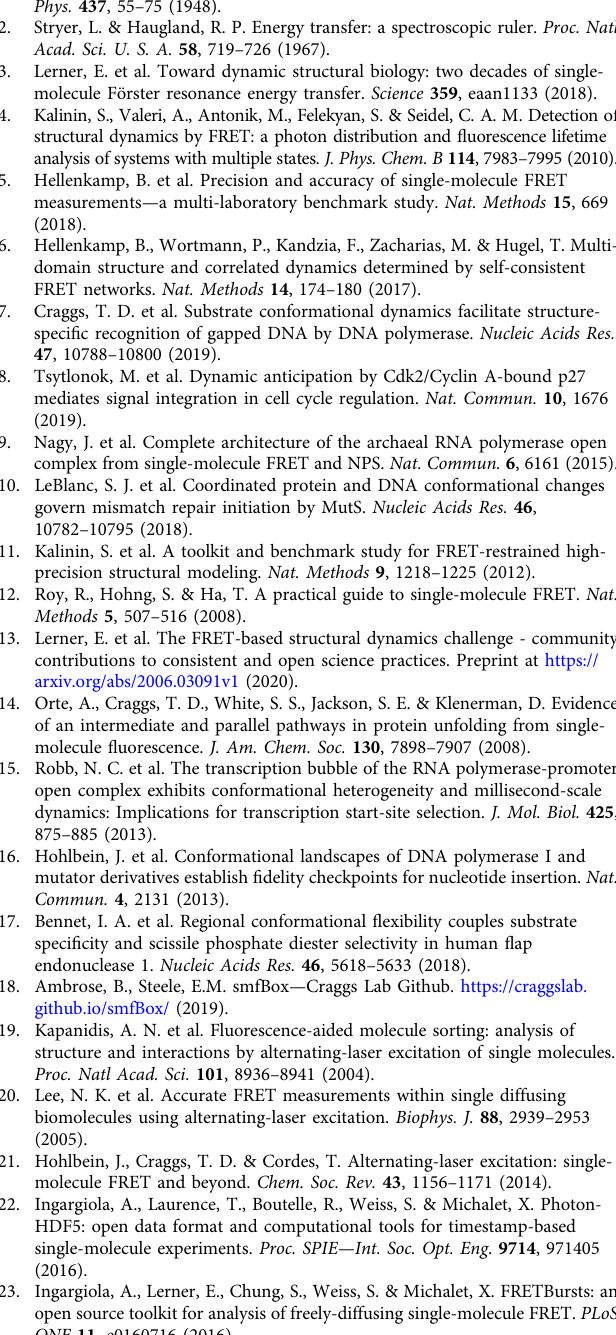
Fig. 2d, e — Hairpin hi-mid-low fret data. The individual rate constant determinations for Fig. 2c are available in the Source Data fi le. Full build instructions for the smfBox,